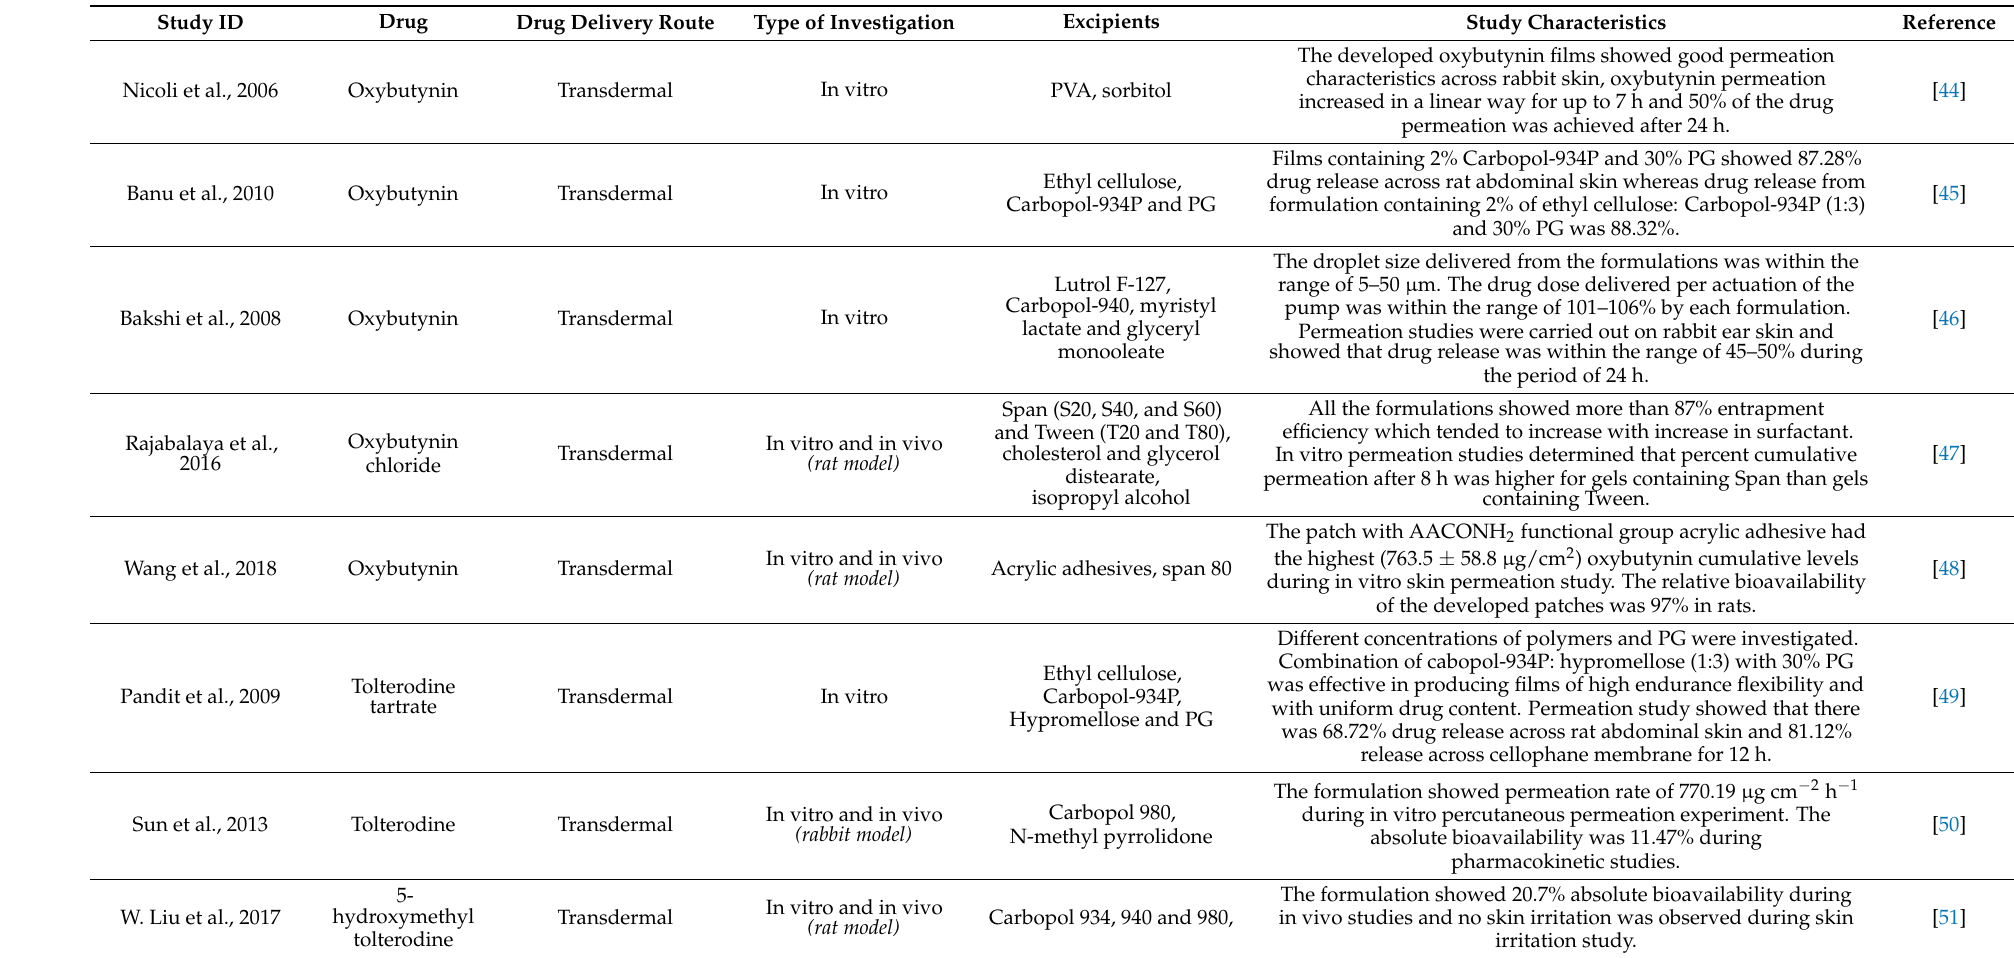
Table 1. Summarised characteristics of eligible